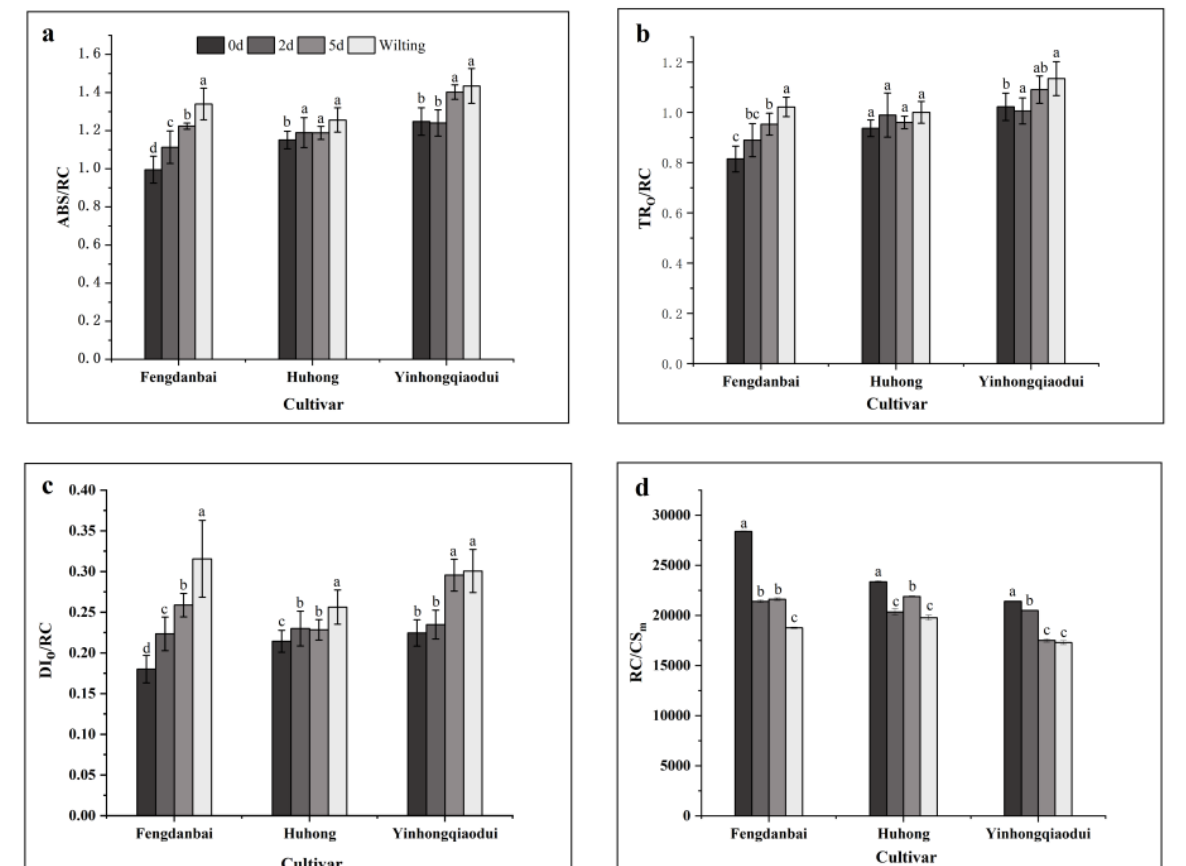
Figure 5. Effects of high-temperature stress on specific activity parameters of ‘Fengdanbai’ ‘Yinhongqiaodui’ and ‘Huhong’ cultivars of peony leaves. Absorption flux (of antenna Chls) per RC (also a measure of PSII apparent antenna size) (ABS/RC; ( a )); trapped energy flux (leading to Q A reduction) per RC (TRo/RC; ( b )); dissipated energy flux per RC (DIo/RC; ( c )); the number of reaction centers per unit area at maximum fluorescence (RC/CS m ; ( d )).